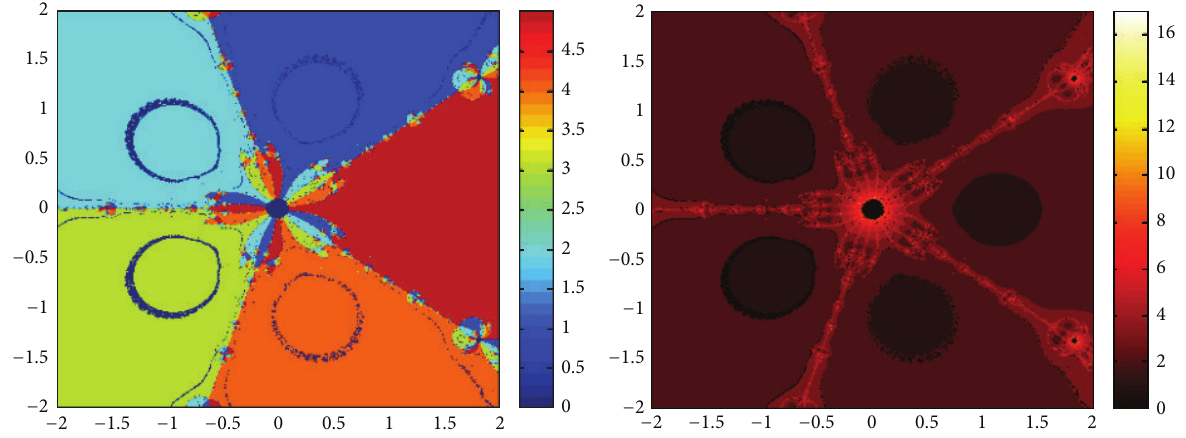
Figure 8: Basins of attraction of (9) for 𝑝 5 (𝑥)